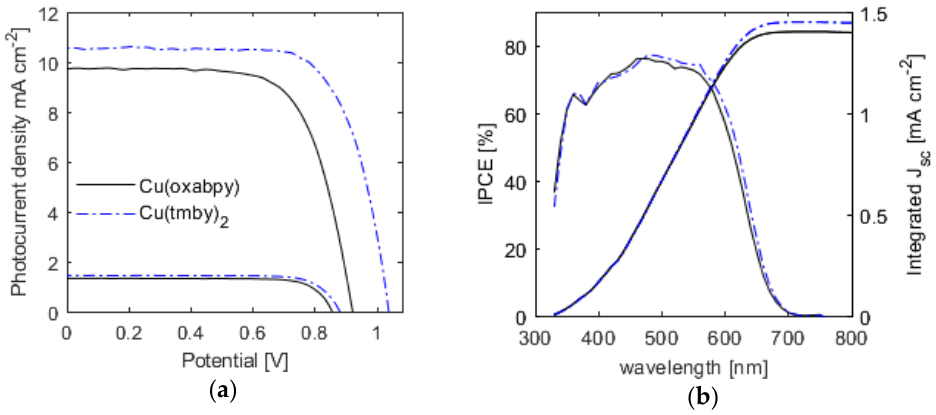
Figure 5. Photovoltaic performance. ( a ) Current density vs. applied potential under standard AM 1.5G illumination and 10% light intensity; ( b ) Incident Photon ‐ to ‐ Current Conversion Efficiency (IPCE) for Y123 ‐ sensitized DSCs (recorded at 10 mW/cm 2 illumination). Table 2. J – V characteristics for Y123 ‐ sensitized solar cells with Cu(tmby) 2 and Cu(oxabpy) electrolyte under full AM 1.5G and under 10% light intensity. For detailed characterization, the reader is referred to Figures S6–S9 in the Supporting Information.